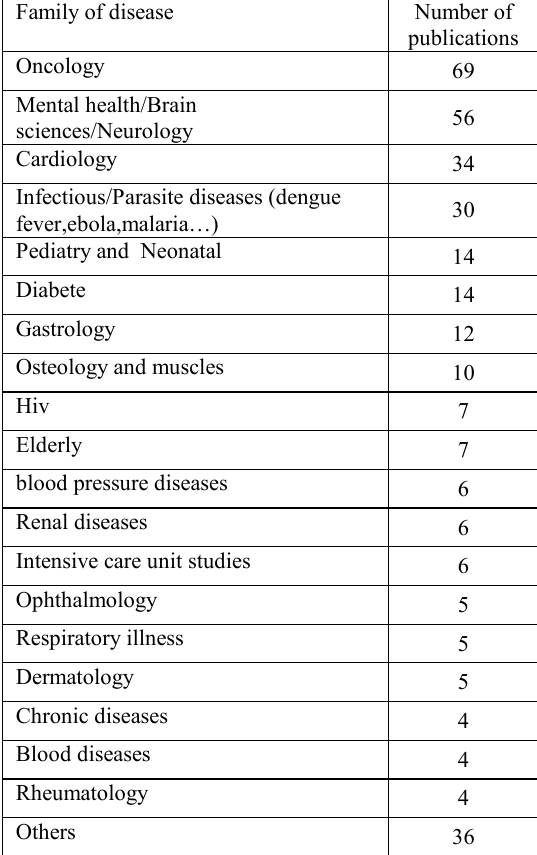
Table 5. Number of publications per Family of Diseases